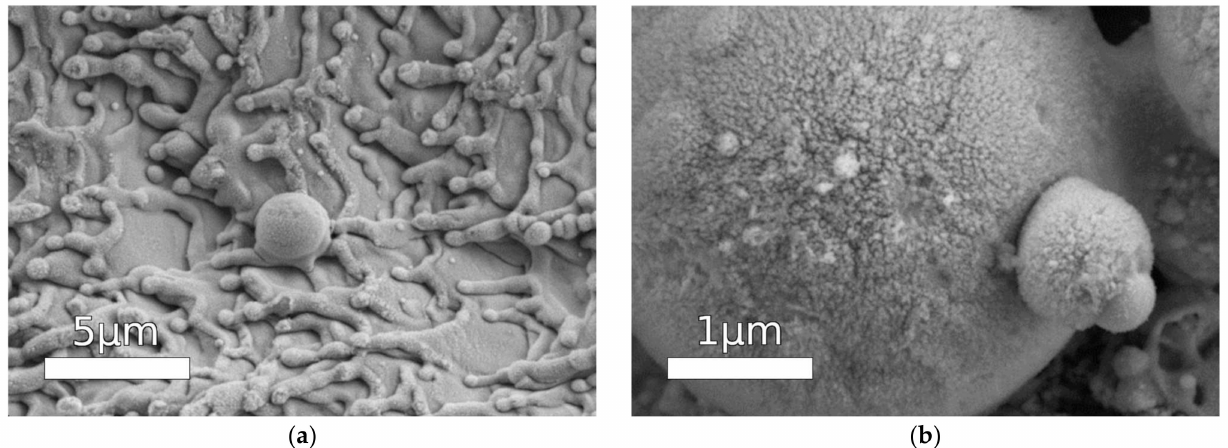
Figure 2. SEM images of the surface of superhydrophobic stainless steel after 90 min of oscillating sand test, ( a ) survey image; ( b ) details of wear at high magnification (source: SEM images for Figure 4 from [78] obtained from authors, reprinted with permission from Pleiades Publishing,